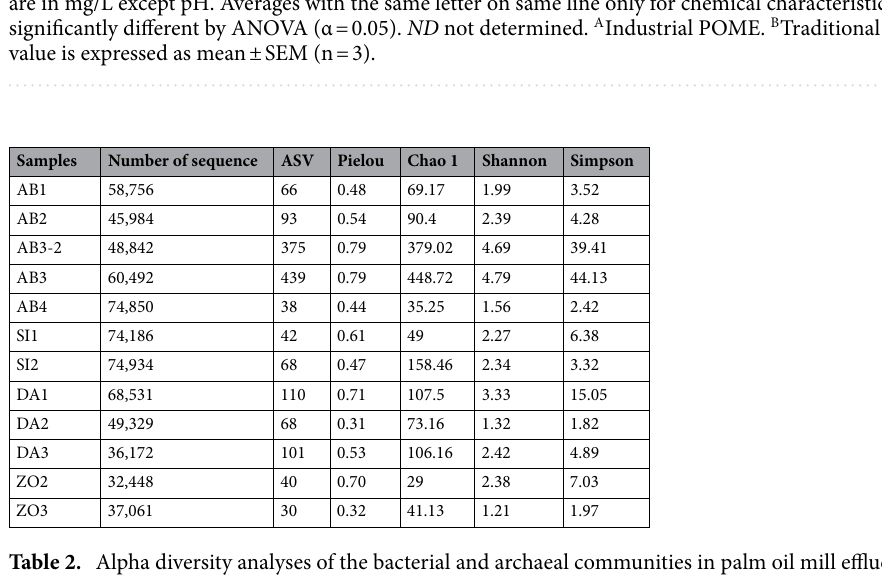
Table 2. Alpha diversity analyses of the bacterial and archaeal communities in palm oil mill effluents (POME) samples.